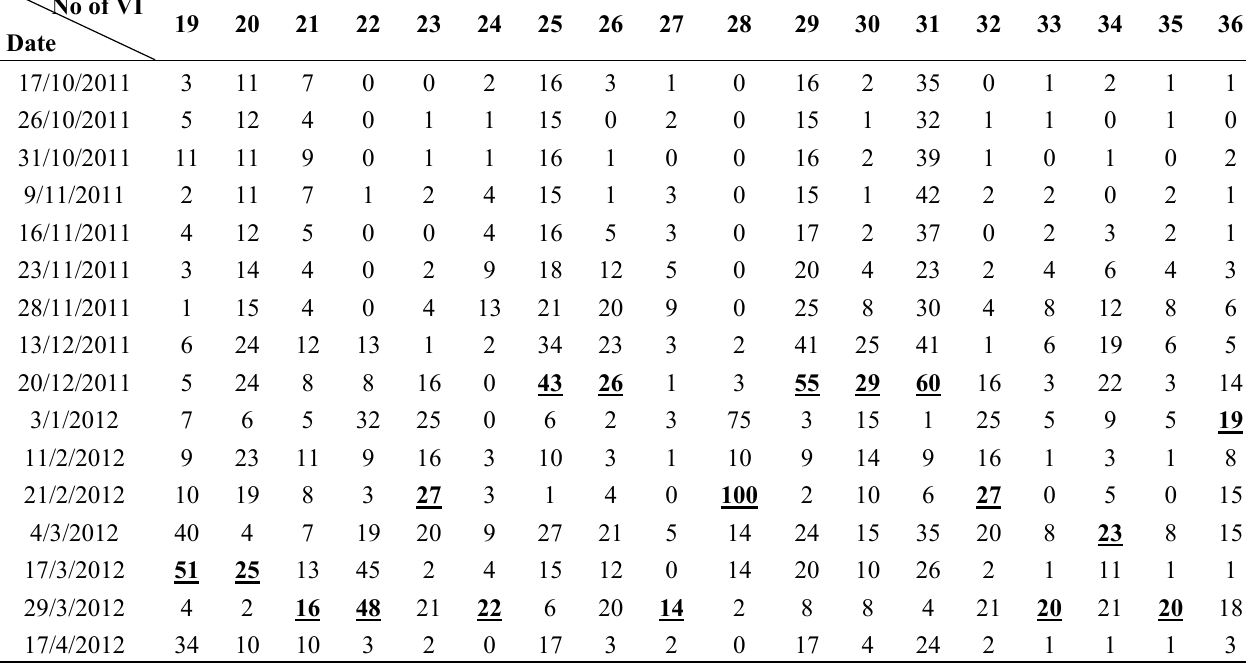
Table 3. VI performance for each narrowband index (19–36 see Table 1) calculated for each field campaign. The higher values for each index are